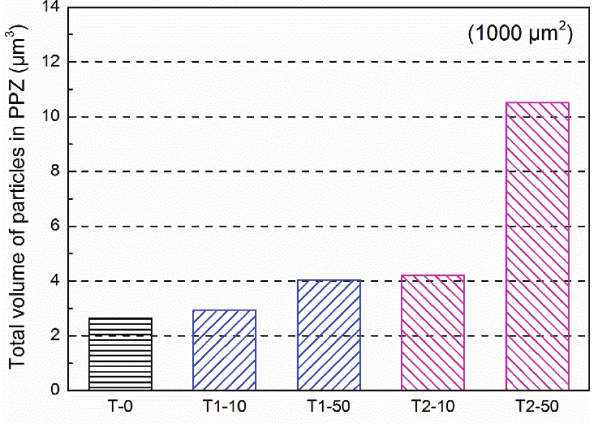
Figure 11: Total volume of oxide particles in 1000 μ m 2 of the PPZ after heat treatment.